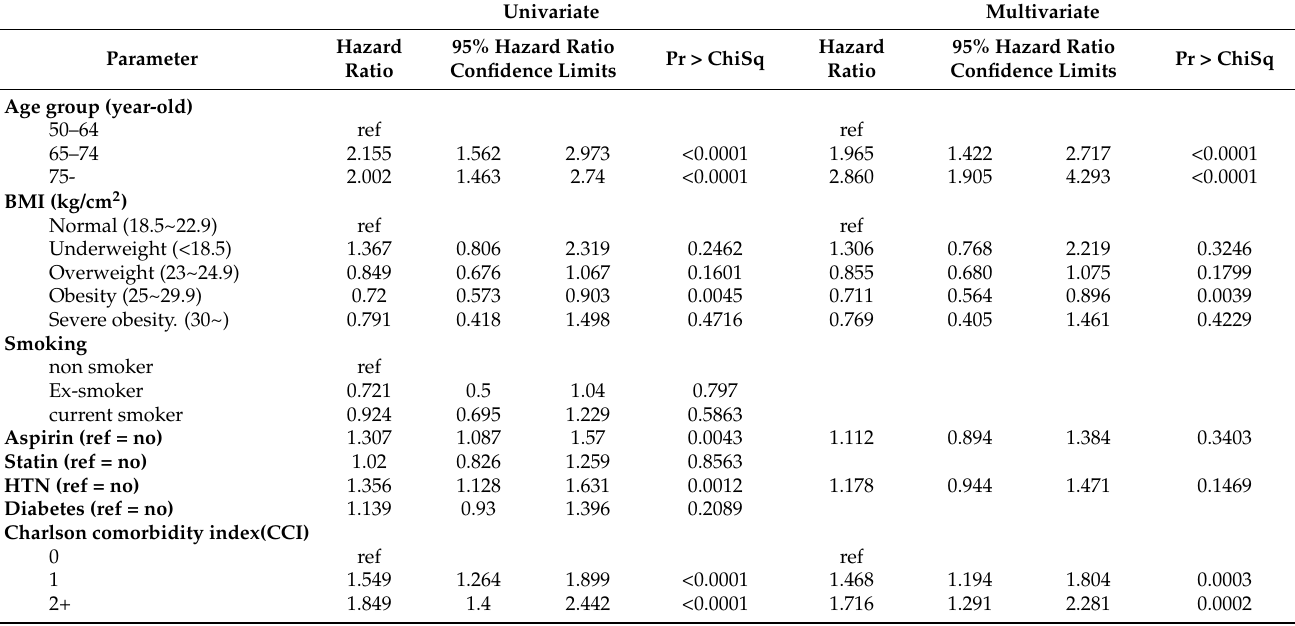
Table 4. Multivariate cox regression of risk factors for dementia among local/regional SEER staging patients after propensity-score